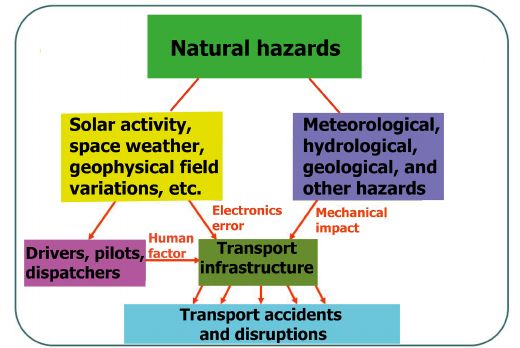
Figure 1. Grouping of natural hazards based on their genesis and impacts on transport